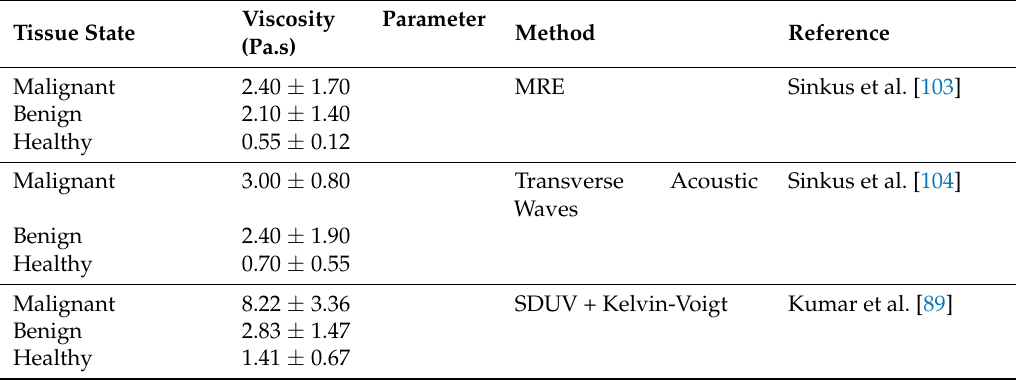
Table 5. Viscosity parameters are calculated for the malignant, benign and healthy states in the breast tissue. The methods applied were magnetic resonance elastography (MRE), transverse acoustic waves and shear wave dispersion ultrasound vibromerty (SDUV). Values are reported as means and standard